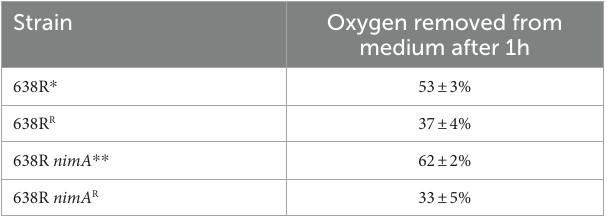
TABLE 5 Oxygen scavenging rates in Bacteroides fragilis strains.